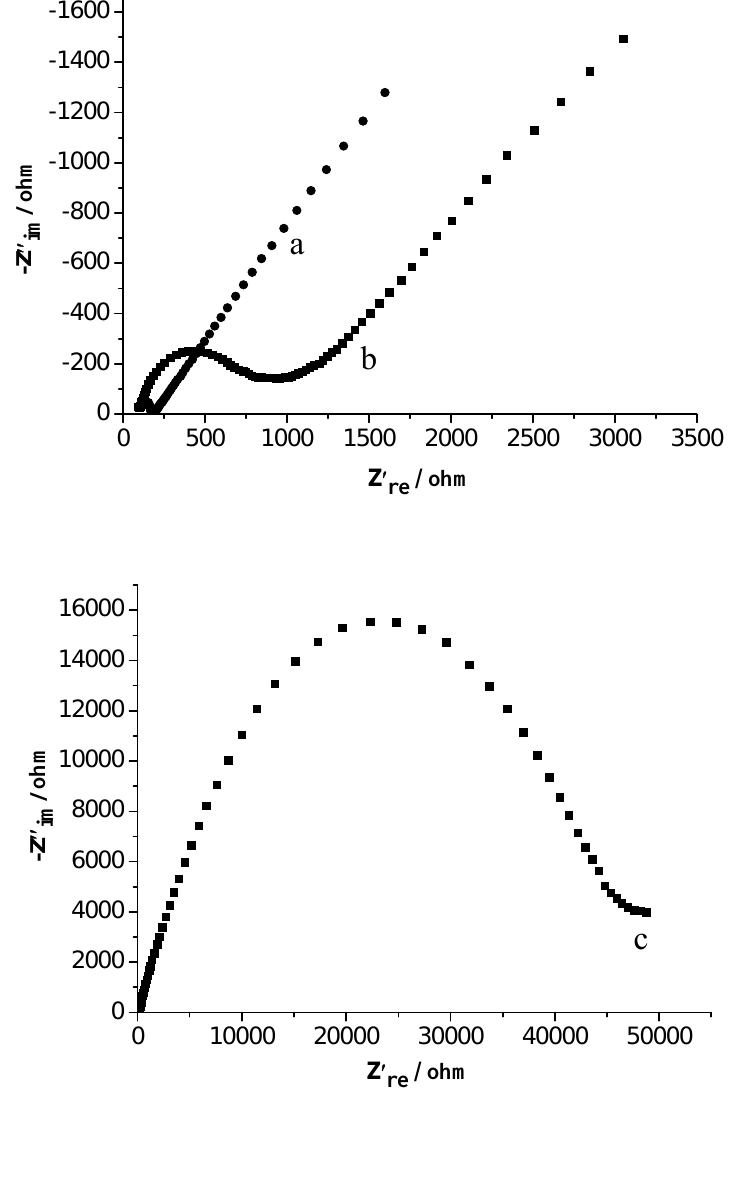
O /CS-GCE (b), the Fe 3 4